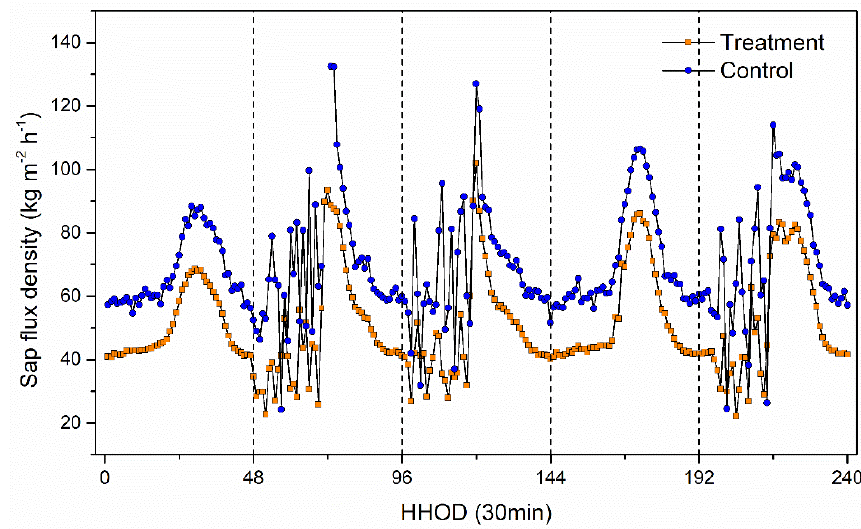
Figure 8. Sap flux density comparison for the treatment and control groups during five observation days in 2015. HHOD means half-hour-of-the-day.